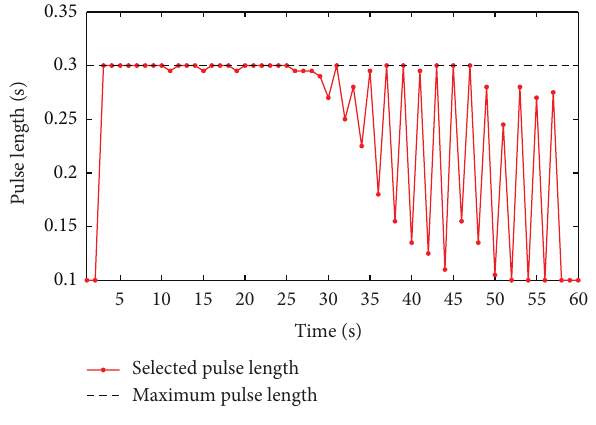
Figure 3: Parameter selection.